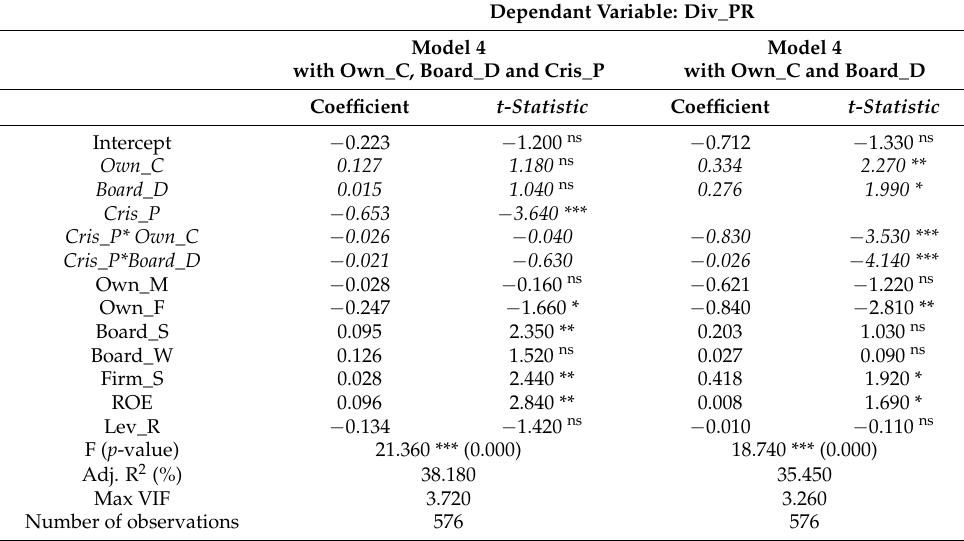
Table 6. Alternative regression for model 4.